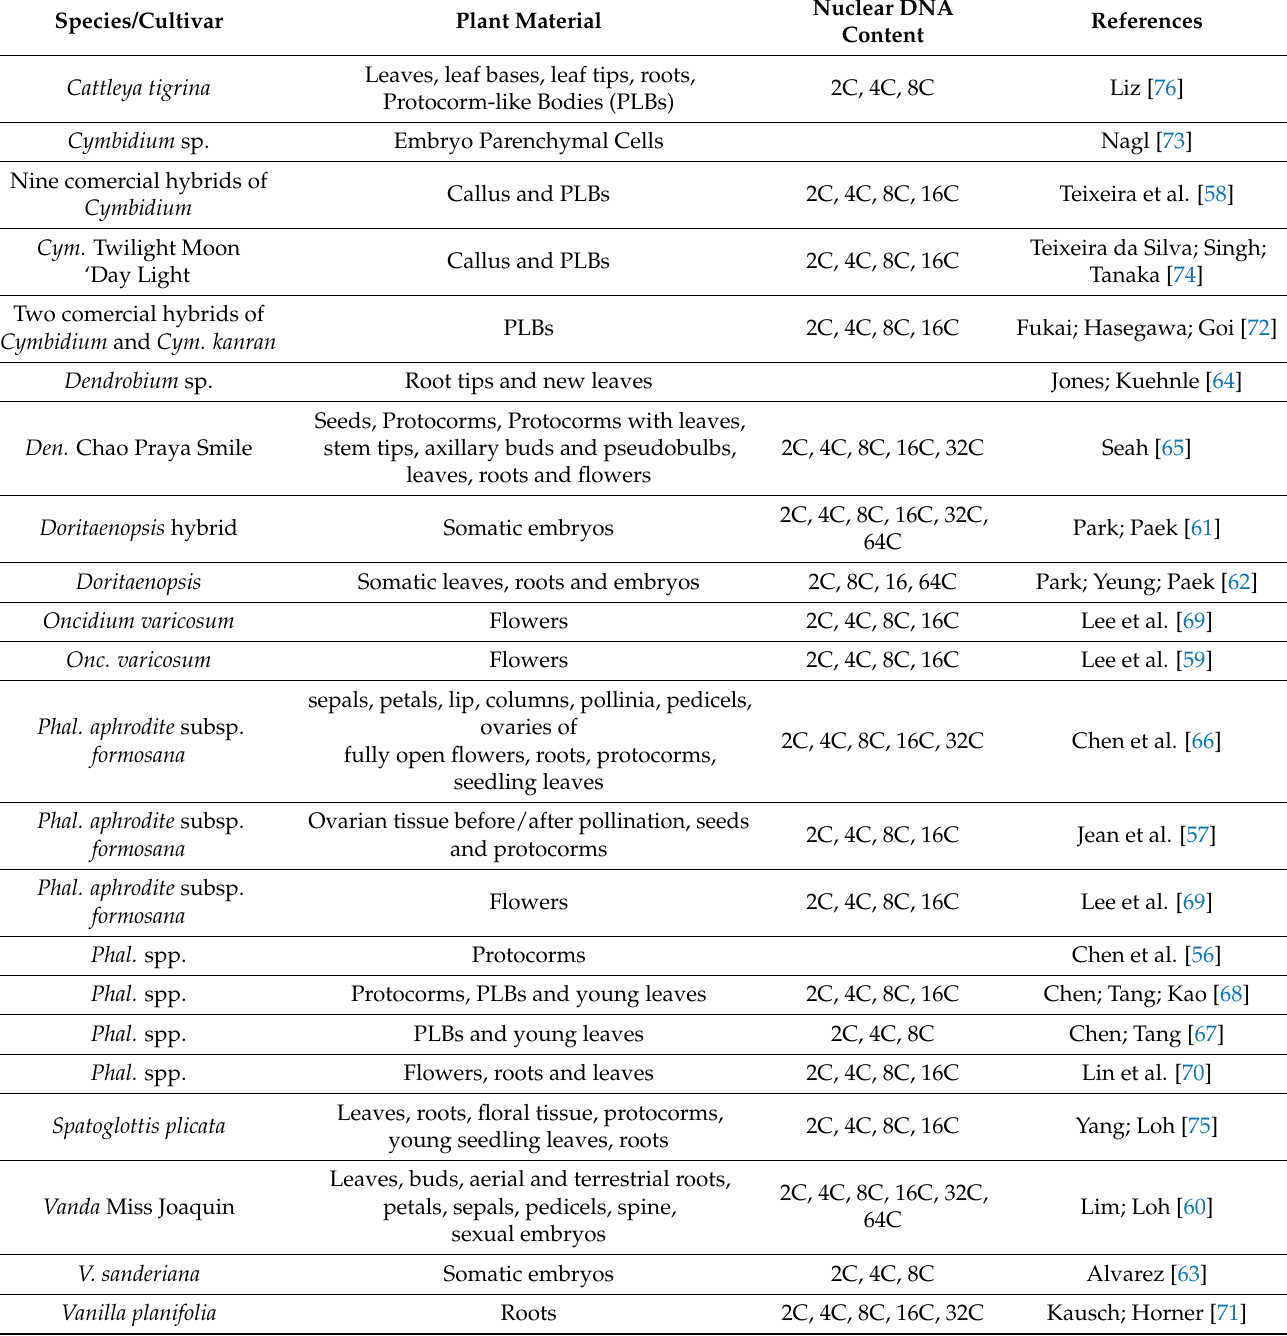
Table 1. Endopolyploidy observed in different orchid